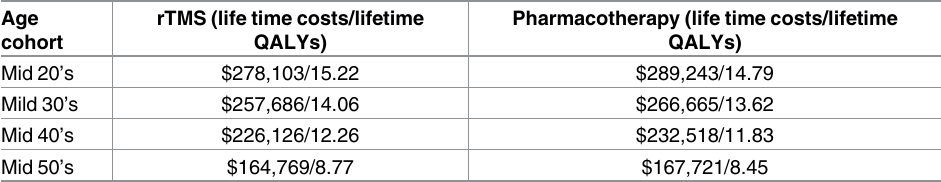
Table 2. Expected values based on age cohort over the life of the patient.